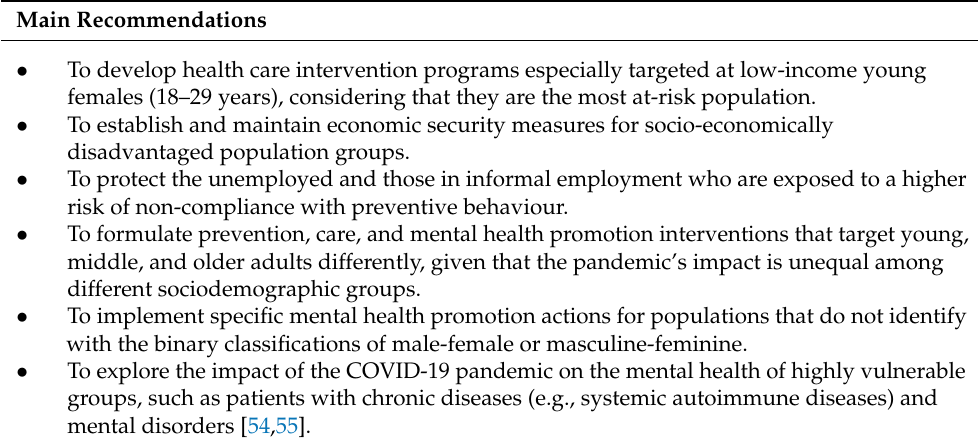
Table 4. Main recommendations from study